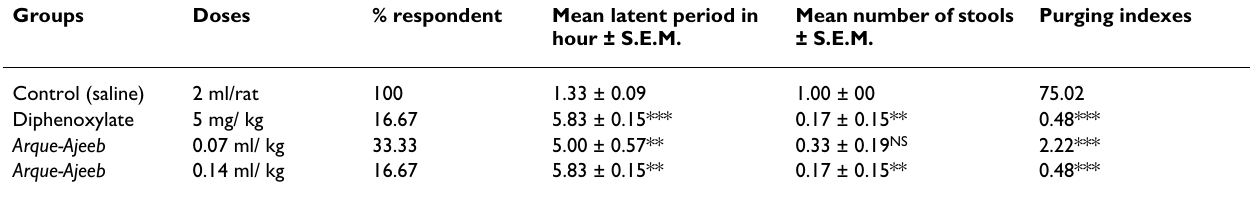
Mean number of stools hour ± S.E.M. ±